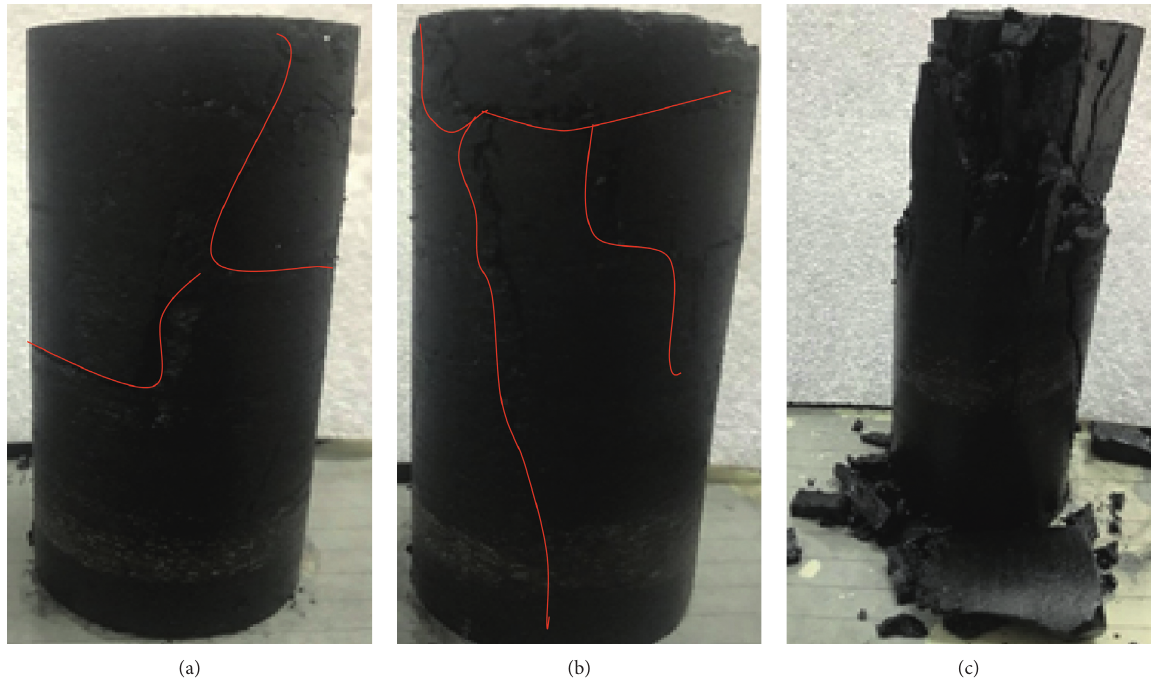
Figure 5: Destruction states of coal samples with different strain rates. (a) No. 1 coal sample. (b) No. 2 coal sample. (c) No. 3 coal